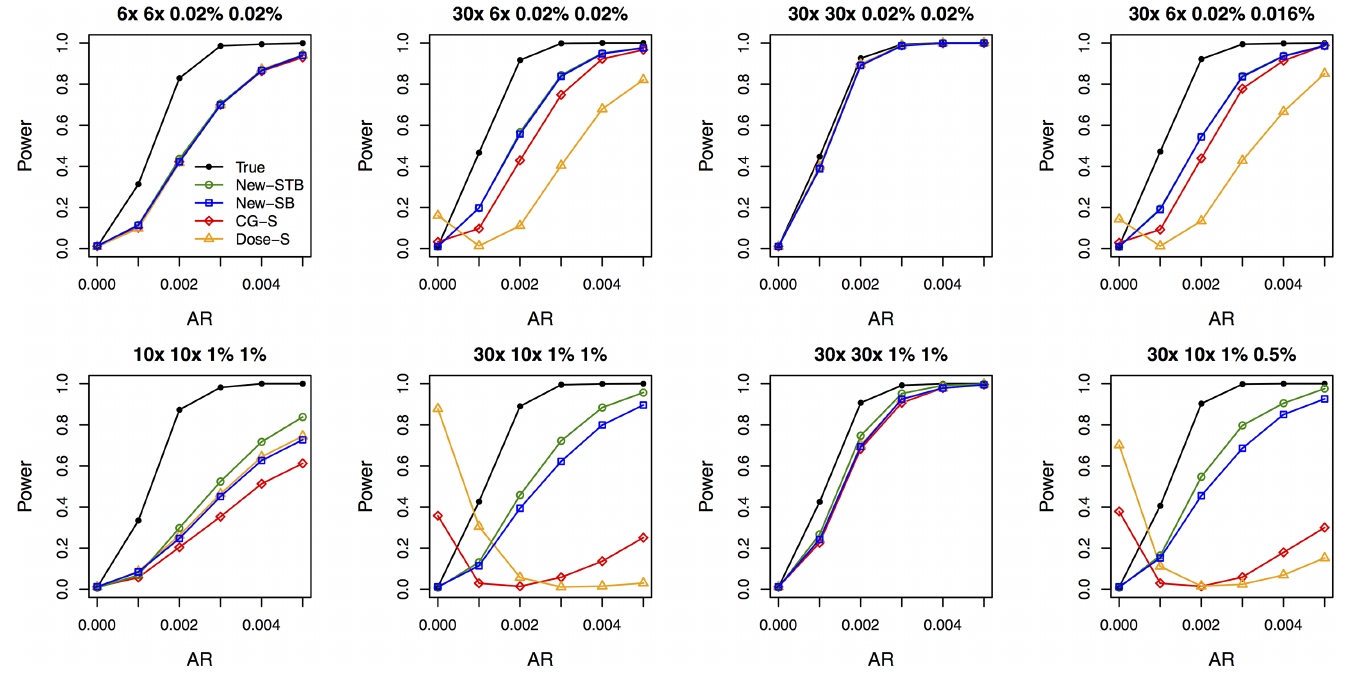
Fig 2. Power of the weighted burden test at the nominal significance level of 0.01. The title of each plot lists the average depths in cases and controls and then the average error rates in cases and controls. AR is the attributable risk per SNV. Each power estimate is based on 1,000 replicates.